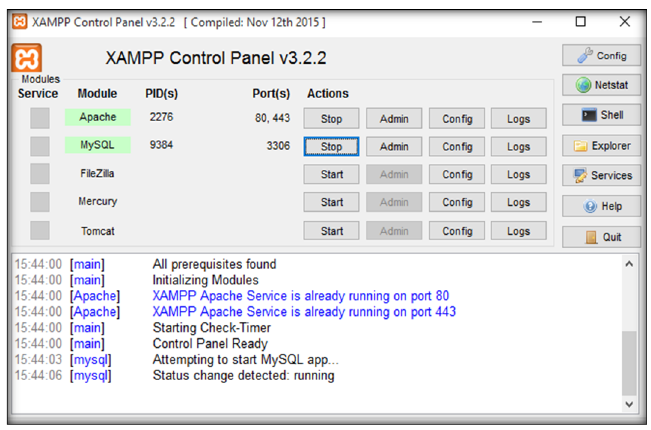
Figure 10. Local server panel control.